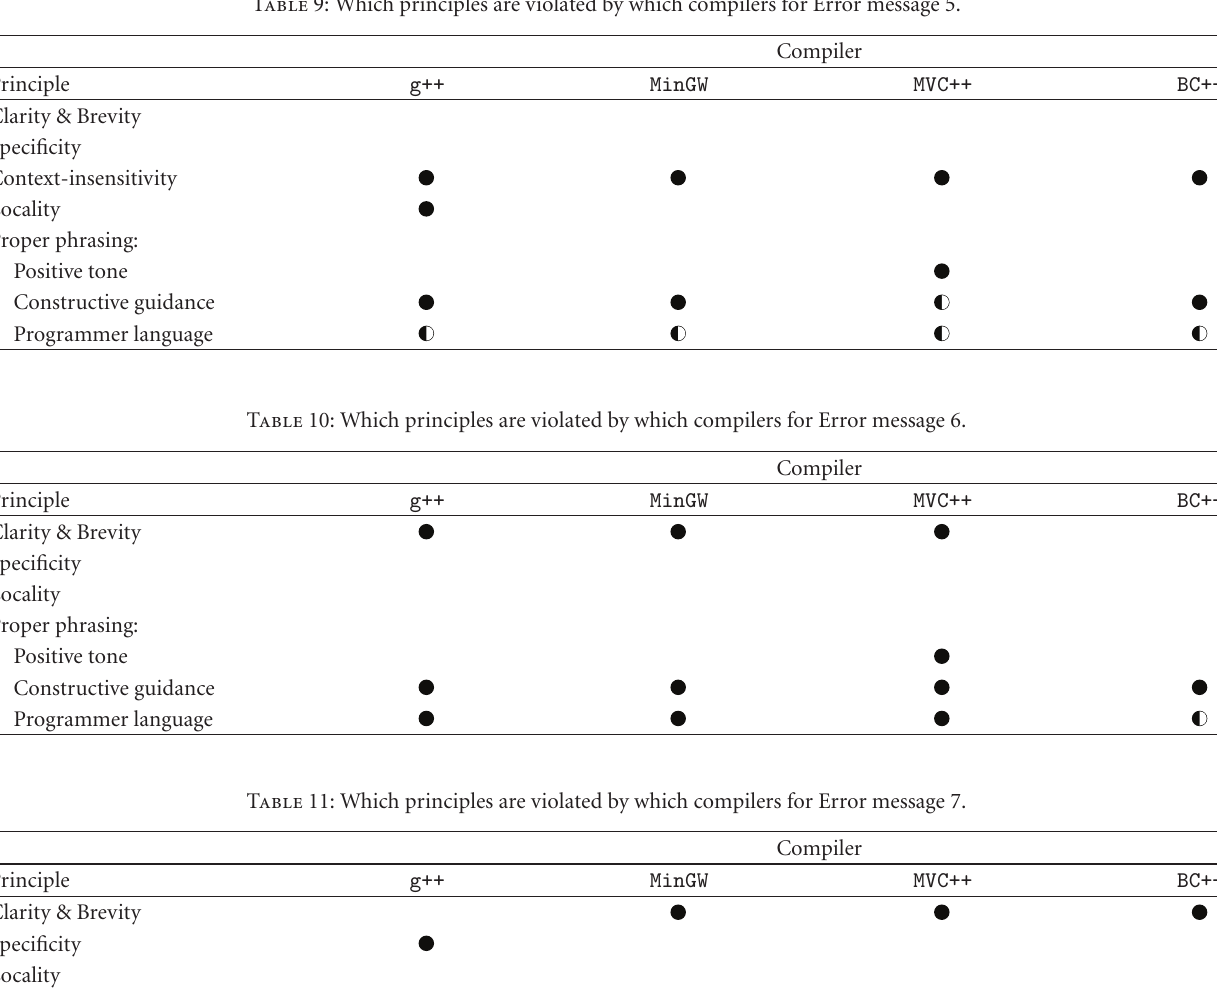
Table 9: Which principles are violated by which compilers for Error message 5.